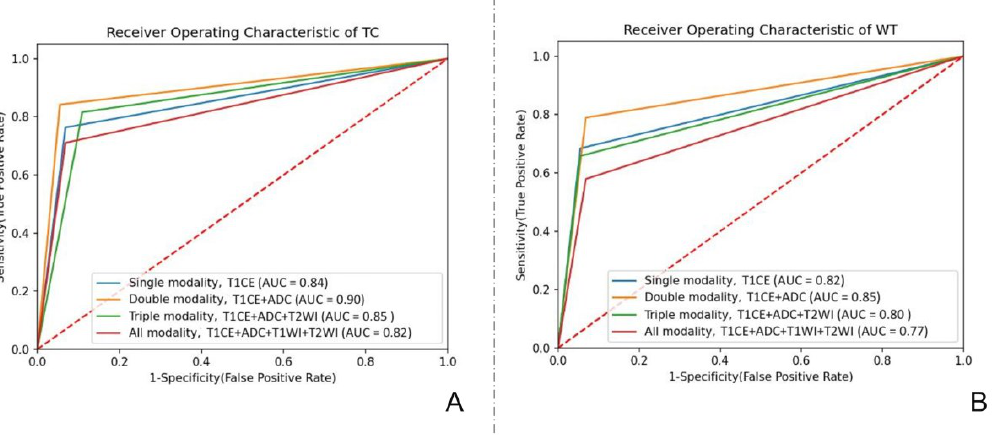
Figure 4. Receiver operating characteristic (ROC) curves based on 2 ROIs of different modal models with the highest AUC values. ( A ) ROC curves based on the ROI of the tumor core of different modal models with the highest AUC values. ( B ) ROC curves based on the ROI of the whole tumor of different modal models with the highest AUC values.